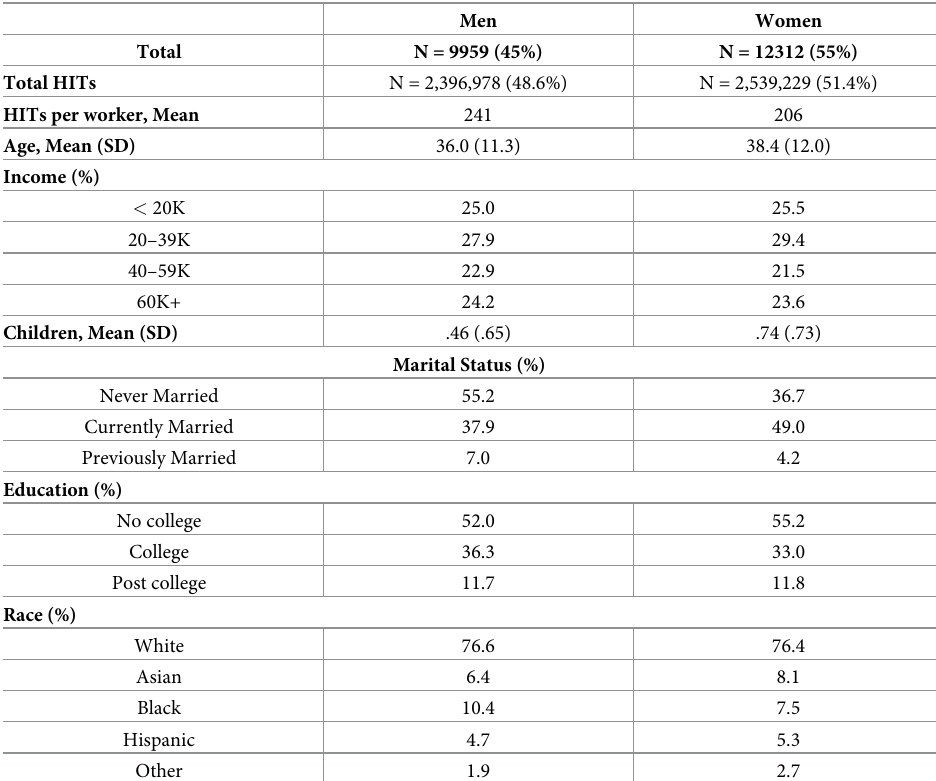
Table 1. Demographic characteristics of analytic